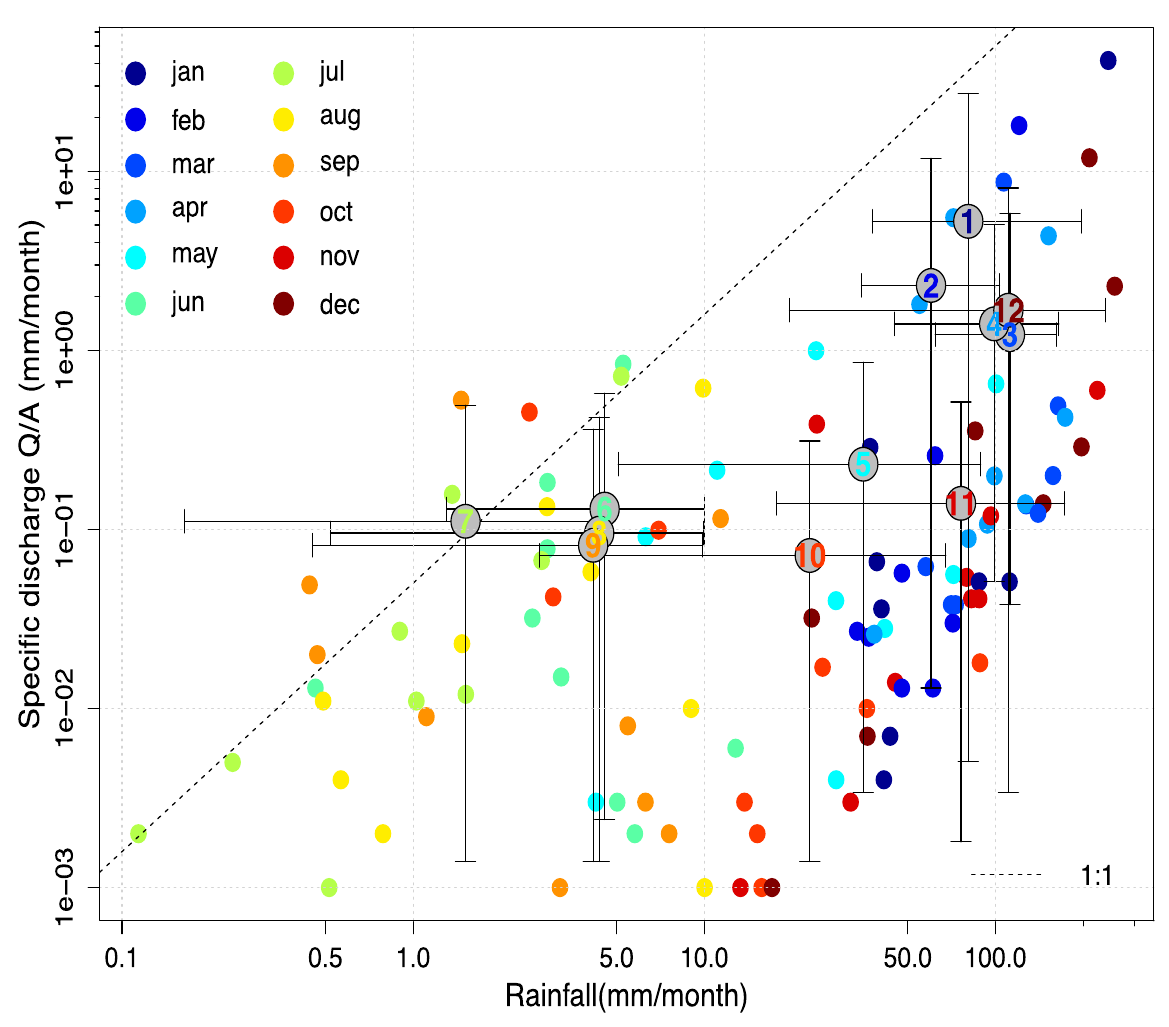
Figure 11. Annual precipitation-discharge hysteresis. Monthly precipitation-simulated runoff. Numbered centers represent monthly mean values for individual months over the study period. Bars represent 5% and 95% quantiles. The dashed line refers to the direct relationship of precipitation and resulting